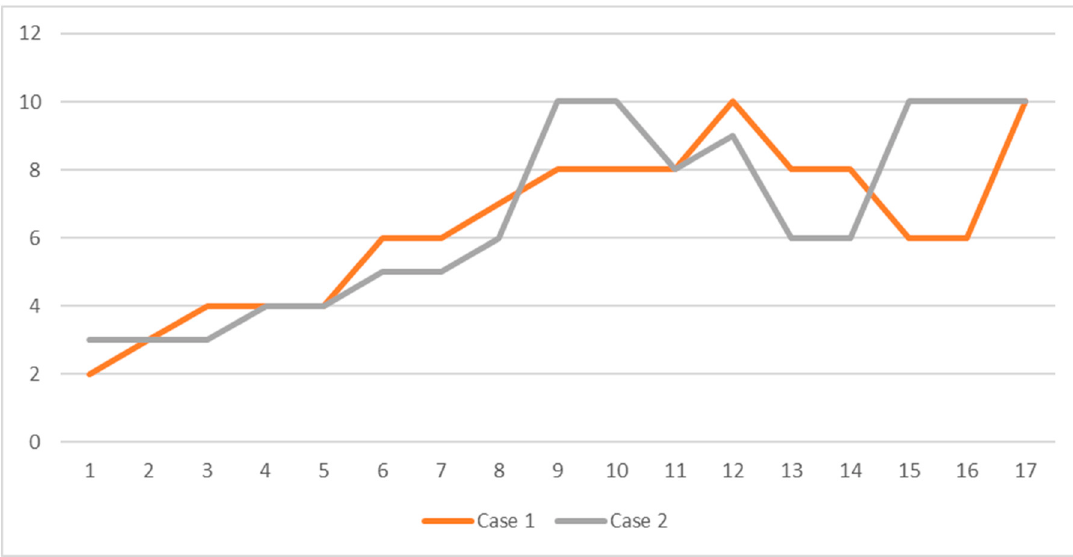
Figure 2. Longitudinal scores.